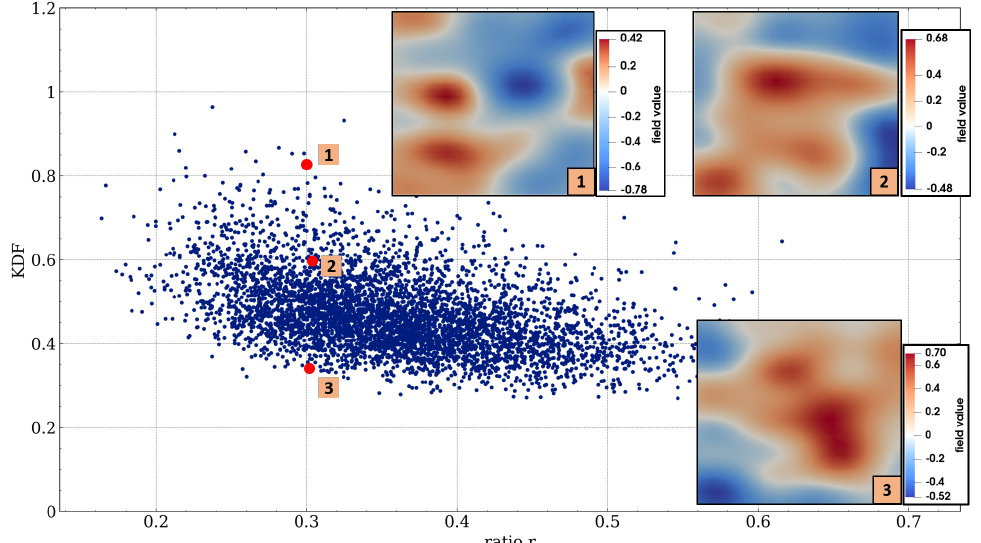
Figure 14. Selection of three exemplary random fields with a similar waviness ratio at the midsurface of the